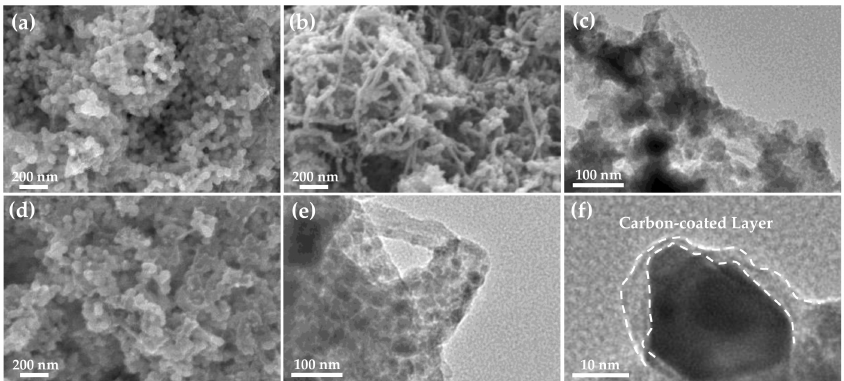
Figure 3. ( a ) SEM image of NiS 2 ; ( b ) SEM image of NiS 2 / CNTs; ( c ) TEM image of NiS 2 / CNTs; ( d ) SEM image of NST / CNTs@C; ( e ) TEM image of NST / CNTs@C; ( f ) RHTEM image of NST / CNTs@C.